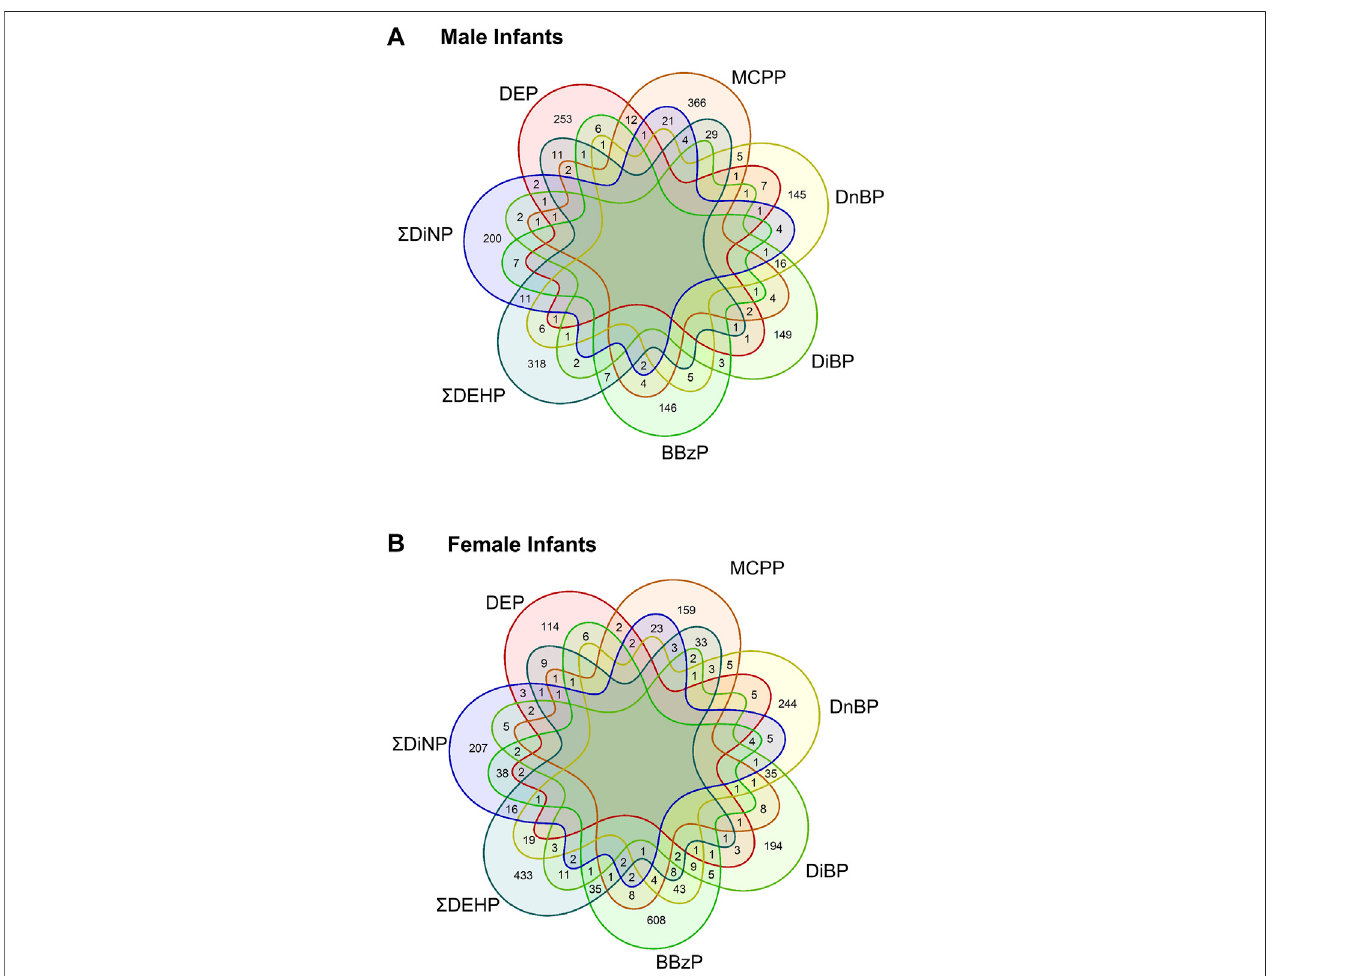
FIGURE 2 | Shared genes in each main model phthalate exposure by infant sex. Venn diagrams of the shared genes in the lists of all genes with a p -value of less than 0.001. Top panel (A) shows shared genes in males, bottom panel (B) showed shared genes in females.